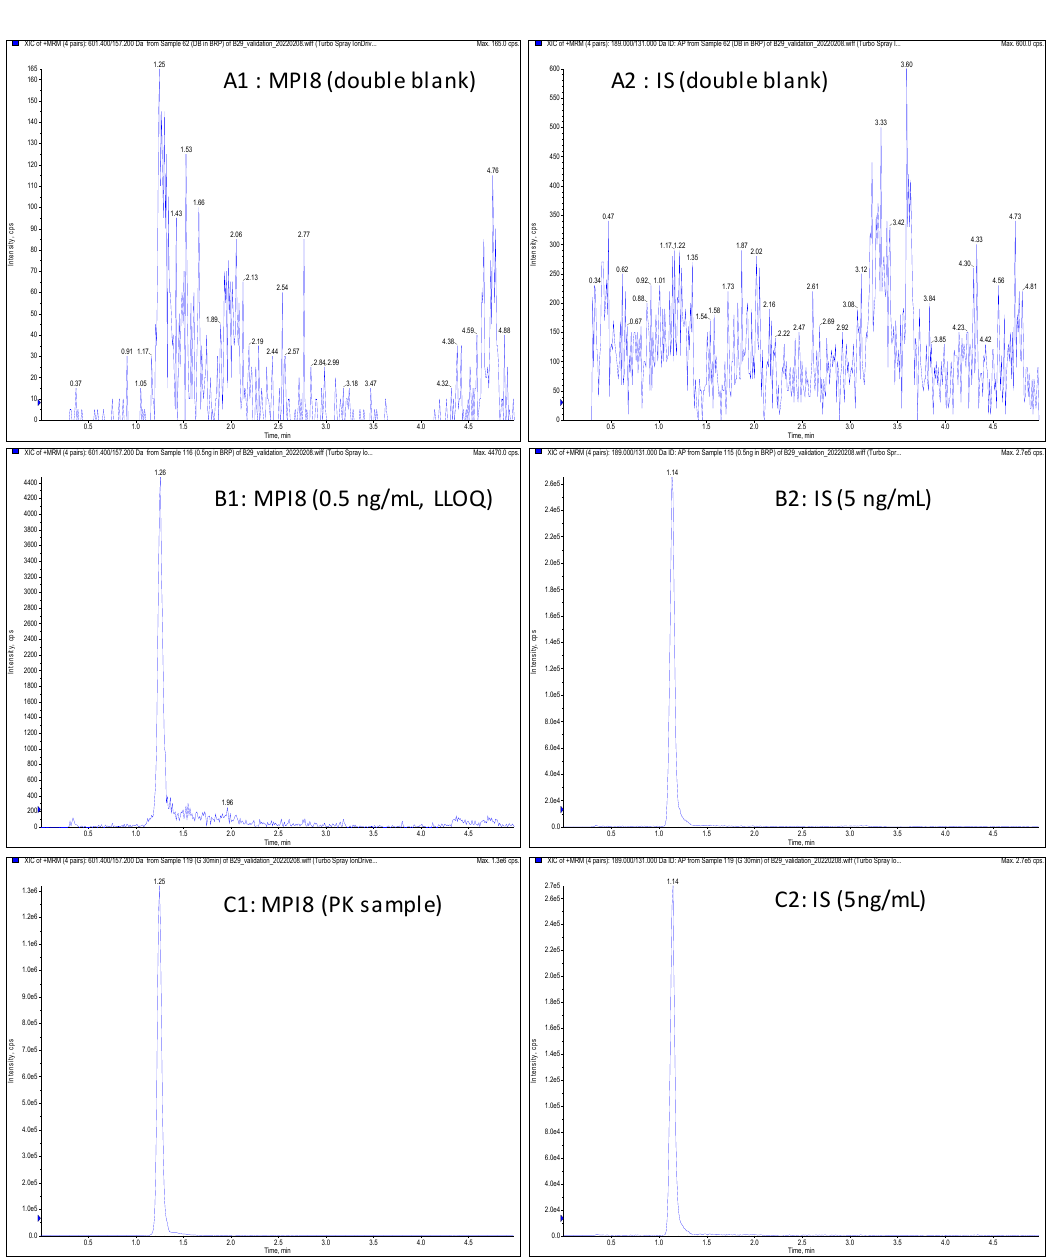
pletely retained on the column, and the retention time mark was 5 min, which was the total running time of the test.